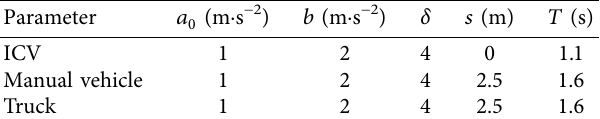
Table 6: The parameter of